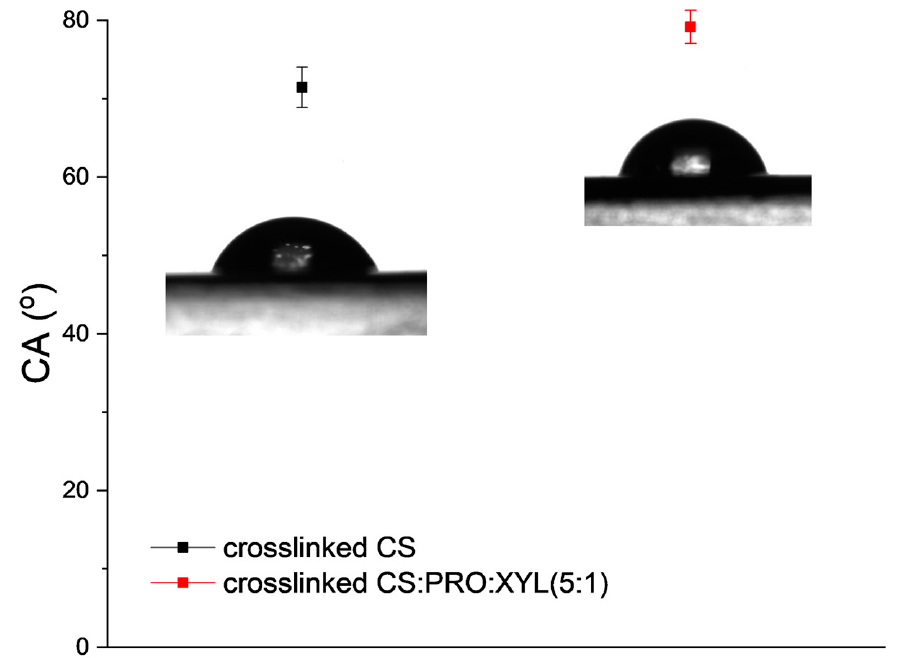
Figure 5. CA values for pristine crosslinked CS and CS:PRO: XYL membranes.